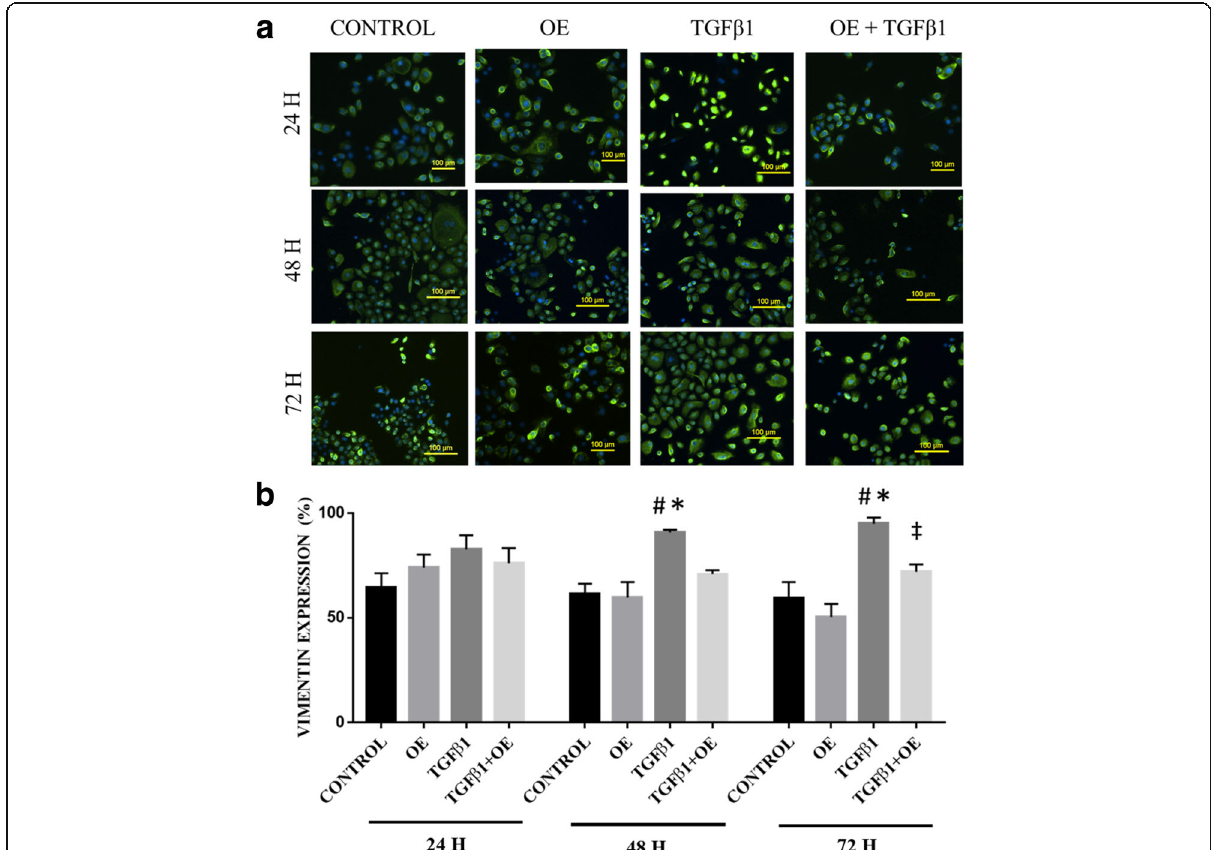
Fig. 5 a Vimentin expression in untreated RECs (control), 0.05% OE-treated RECs (OE), RECs induced to EMT with 5 ng/ml TGF β 1 (TGF β 1) and RECs induced to EMT with TGF β 1 and treated with OE (TGF β 1 + OE) from 0 h until 72 h. Green cytoplasm indicates vimentin expression, and blue is DAPI-stained nuclei. b Vimentin expression (%) vs time per group. * P < 0.05 indicates significant differences when compared with the control, # P < 0.05 indicates significant differences when compared with OE, ‡ P < 0.05